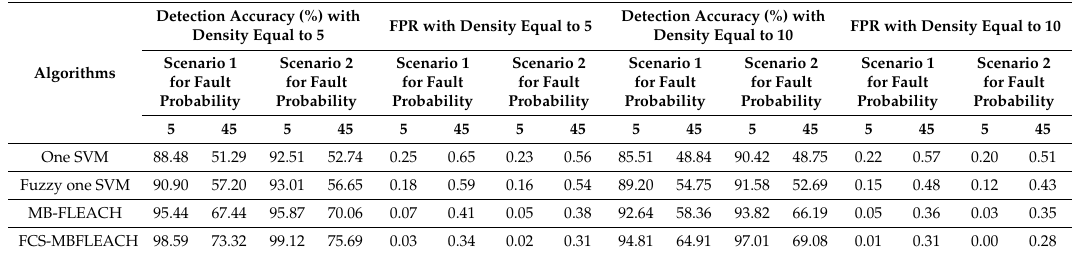
Table 5. A comparison between the proposed algorithms in terms of detection accuracy and FPR